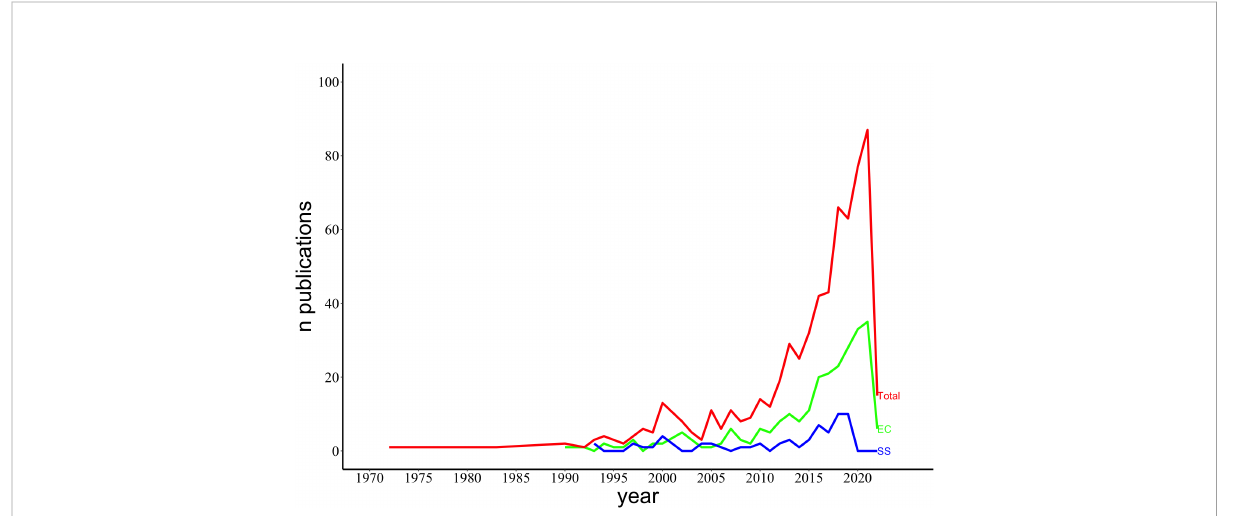
FIGURE 2 Number of documents published annually related to mangrove restoration in SE Asia. Total - all document types; EC, peer-reviewed articles with ecological attributes; SS, peer-reviewed articles with social